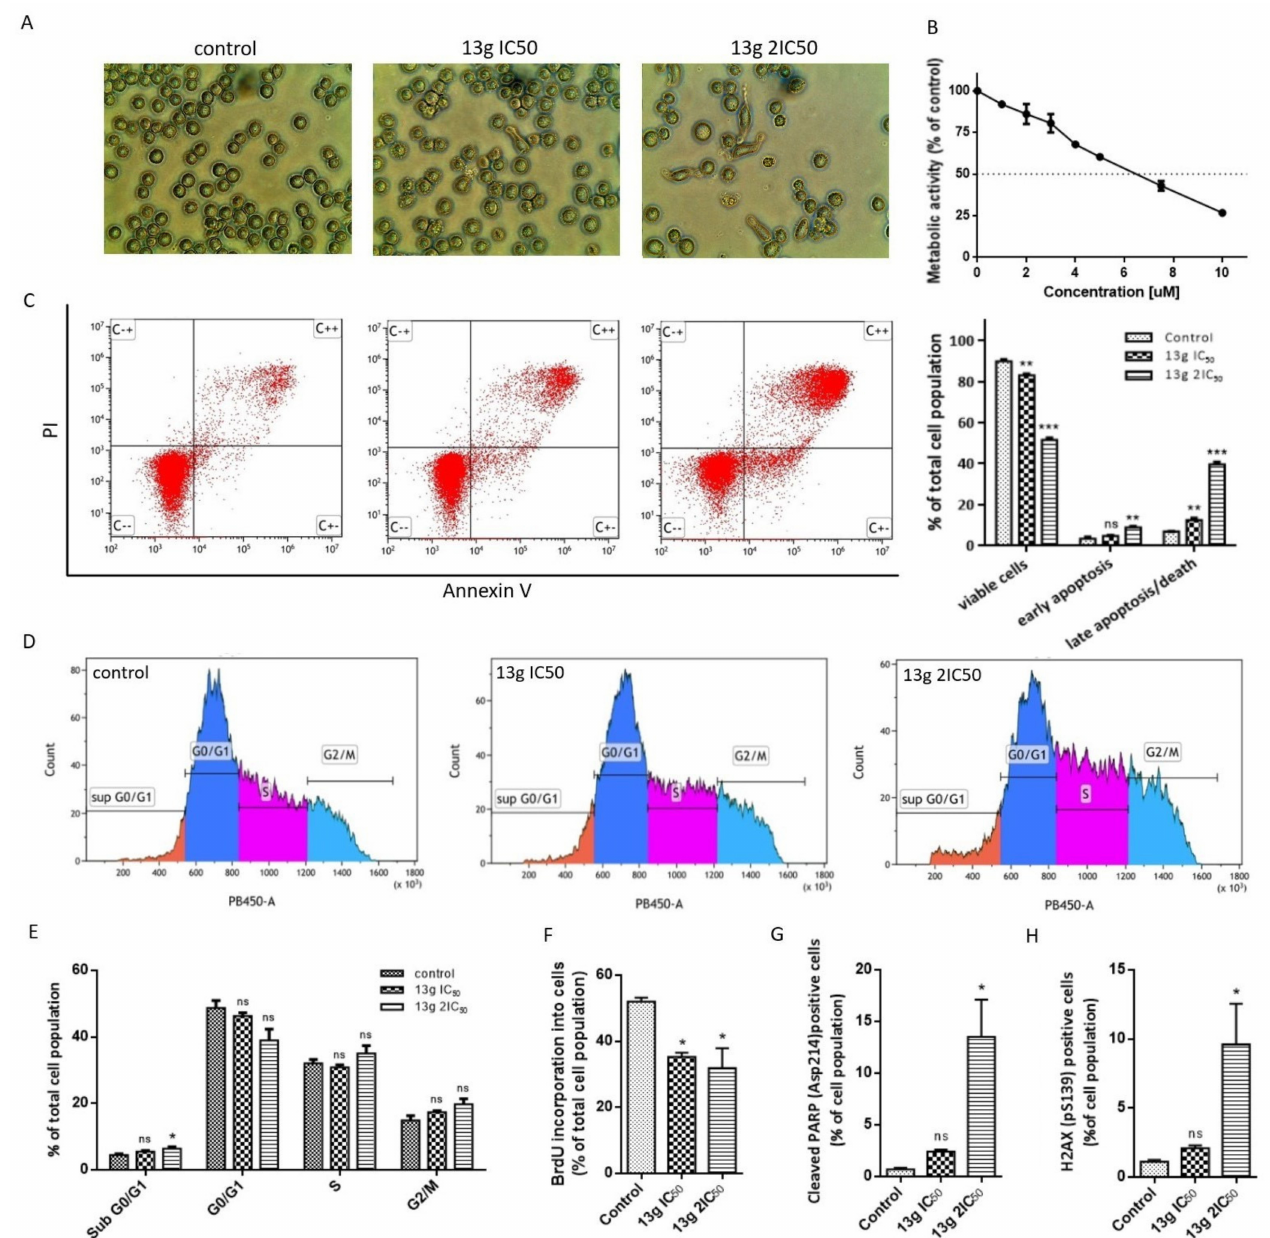
Figure 6. Effect of 13g on HL-60 cells after 24h incubation. ( A )—Morphological changes of HL- 60 cells treated with 13g at IC 50 and 2IC 50 concentrations observed under a light microscope. ( B )—Metabolic activity of HL-60 cells treated with increasing concentrations of 13d assessed by MTT assay. ( C )—HL-60 cells treated with 13g at IC 50 and 2 IC 50 concentrations stained with An- nexin V and PI were analyzed by flow cytometry. ( D – H )—Cells treated with 13g at IC 50 and 2 IC 50 concentrations were stained with Anti-BrdU, Anti-Cleaved-PARP (Asp214) and Anti-H2AX (pS139) antibodies and DAPI solution and analyzed by flow cytometry. The error bars represent means of three replicates ± SEM. ns—statistically non-significant; * p < 0.05, ** p < 0.01, *** p < 0.001 were considered significant in comparison to untreated